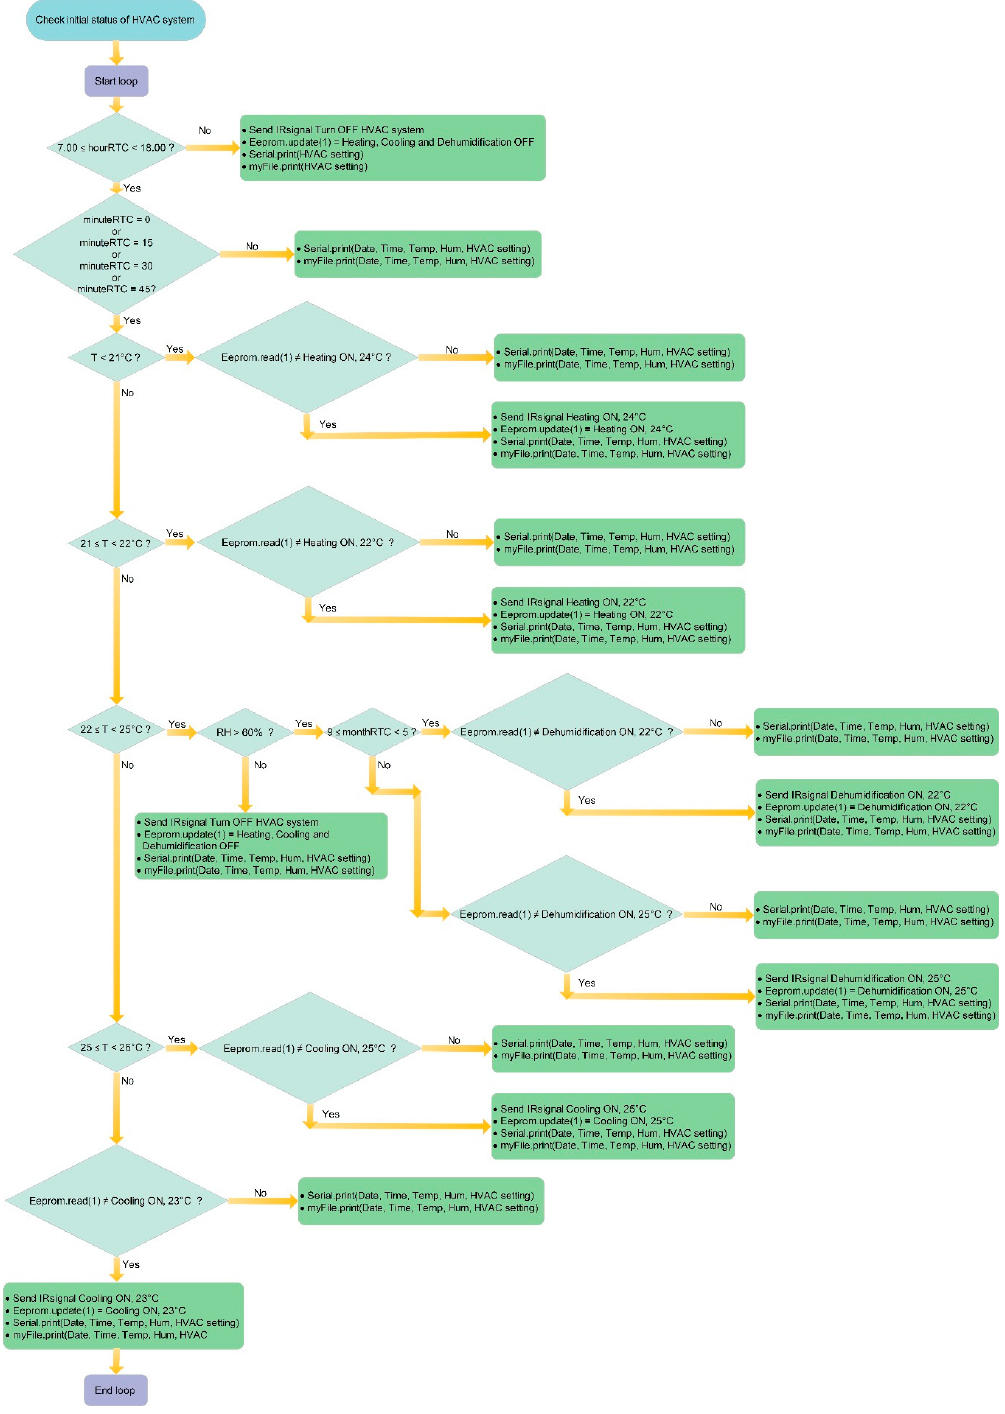
Figure 5. Smart Lamp: management algorithm of HVAC system.